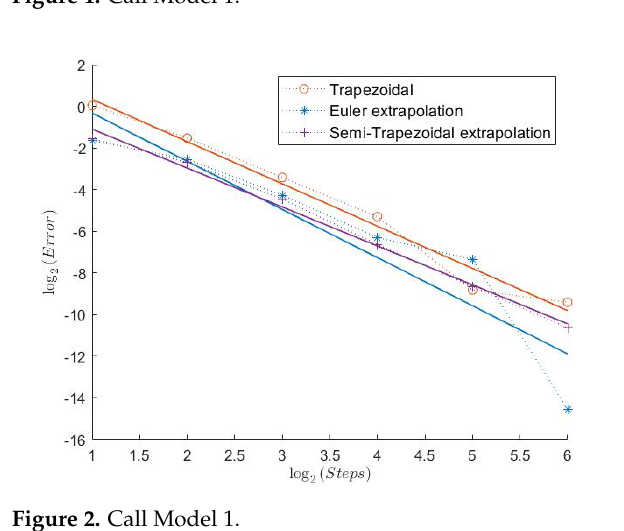
Figure 2. Call Model 1.